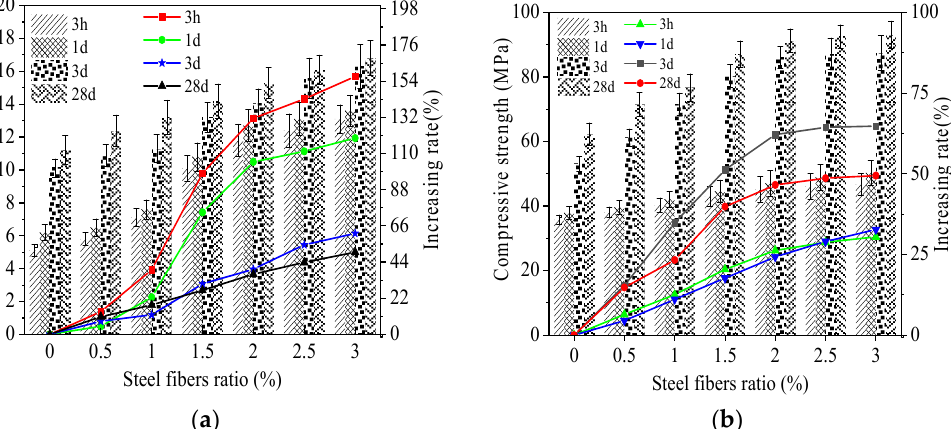
Figure 7. The mechanical strengths of MPC-RPC. ( a ) The flexural strength. ( b ) The compressive strength.